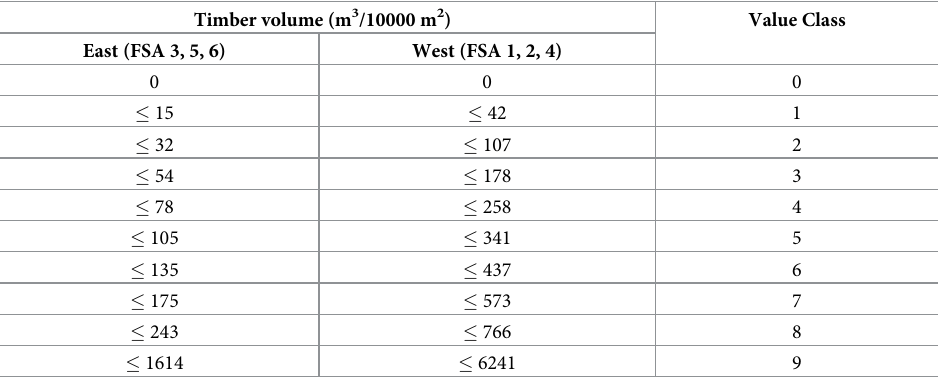
Table 3. Classification of timber volume for value assignment and fire response